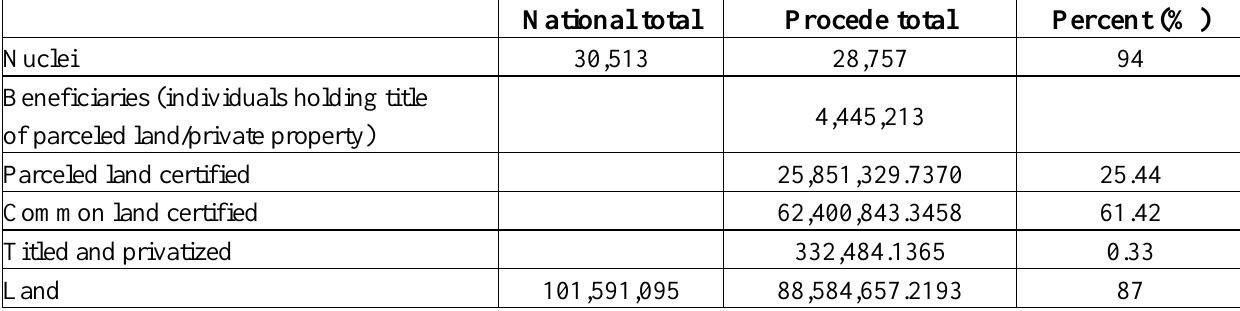
Table 1. Historical progress of PROCEDE (in hectares), 1993 to 2006 (Adapted from